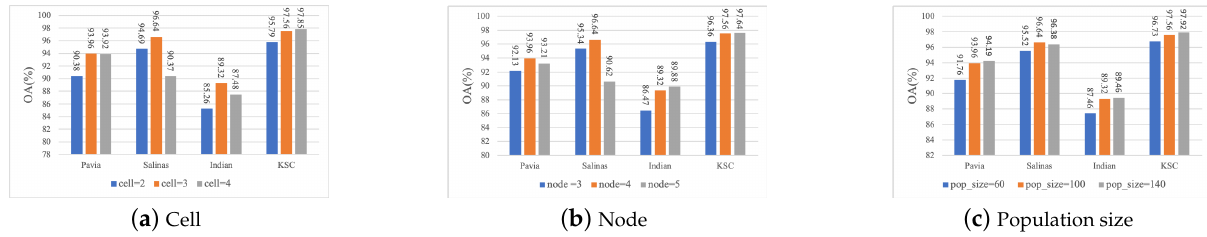
Figure 6. Classification results of different models searched by CPSO-Net with different numbers of cells, intermediate nodes, and population sizes based on four biased hyperspectral image (HSI) datasets.